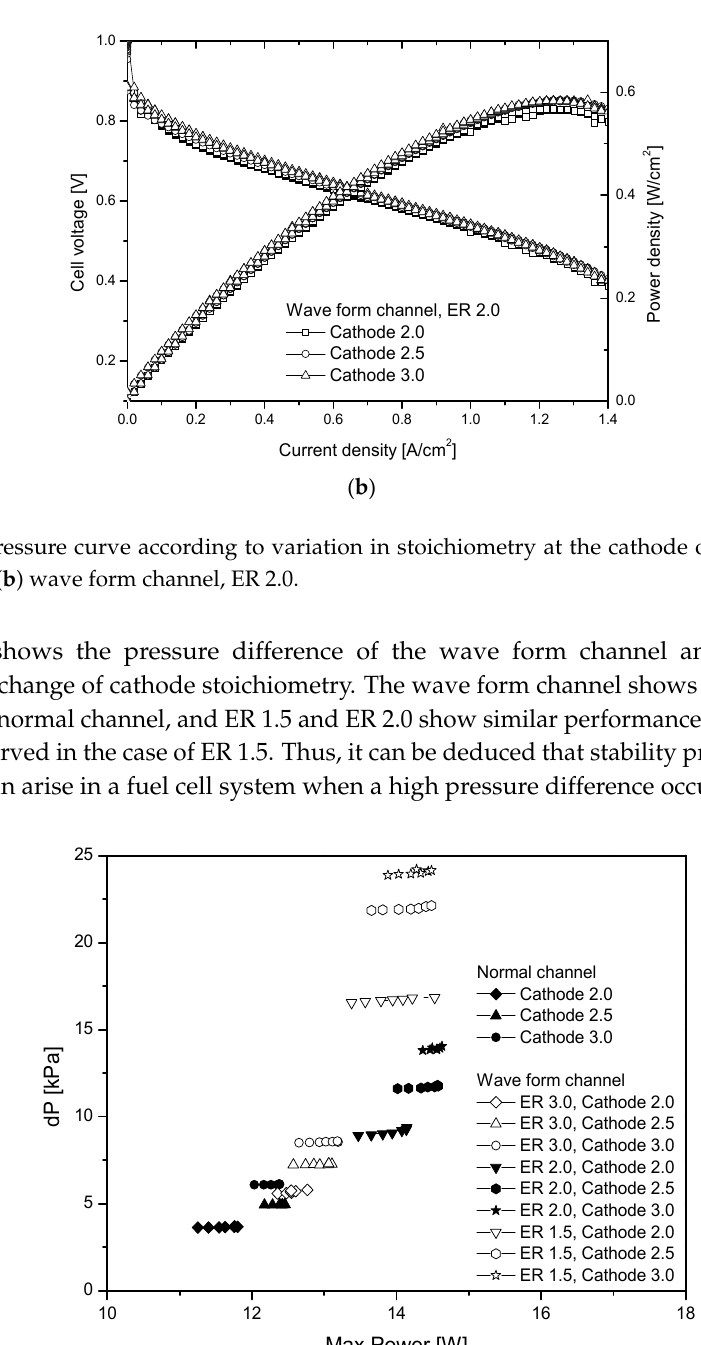
Figure 13. Pressure difference of the normal channel and wave form channel with varied ER, according to variation in the cathode stoichiometry.